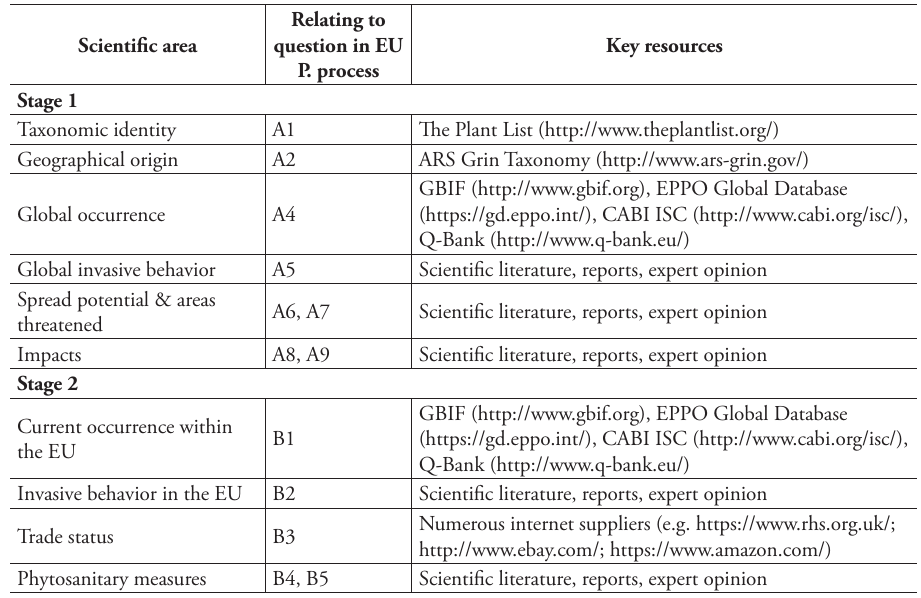
Table 1. Key information sources. Information resources utilised when collecting information on the